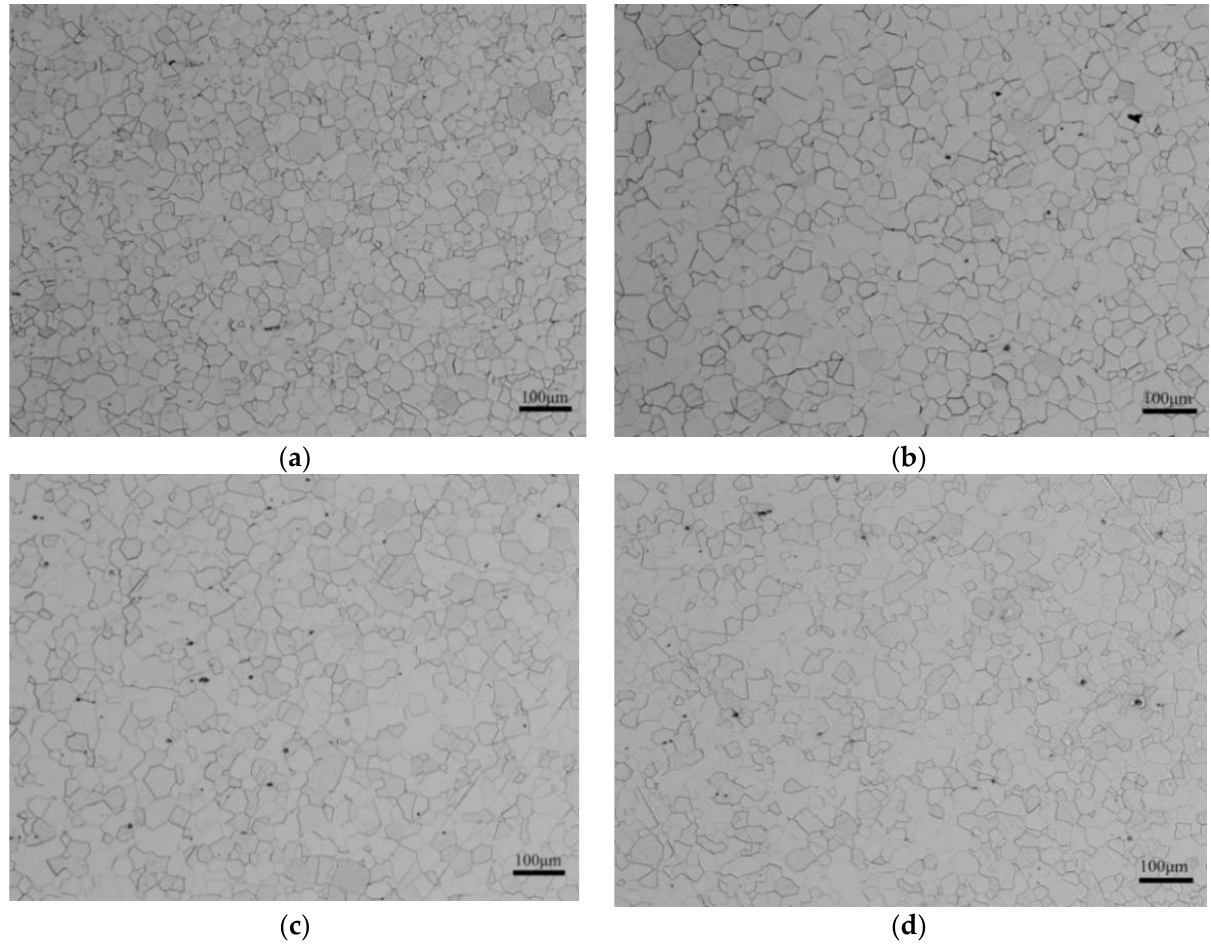
Figure 5. Microstructure of experimental steels: ( a ) 0.06%P, ( b ) 0.10%P, ( c ) 0.14%P, and ( d ) 0.18%P. The statistical results of the average grain size in different target P-bearing samples of the finished samples are shown in Figure 6. Figure 7 shows the percentage of grain quantity with different sizes of the total grains in different P-targeted samples. According to the results, the average grain size of the samples was 23 µ m, 24 µ m, 26 µ m, and 21 µ m with the 0.06%, 0.10%, 0.14%, and 0.18% target phosphorus content in the samples, respectively. The average grain size increased at first and then decreased after the target phosphorus content was attained at 0.18%. Phosphorus segregation at grain boundaries can prevent grain boundaries from migration, which probably prevents grain growth. The standard deviation of the grain size was 13 µ m for the 0.06%P-targeted and 0.18%P-targeted samples, while it was 15 µ m for the 0.10%P-targeted and 0.14%P-targeted samples. Combined